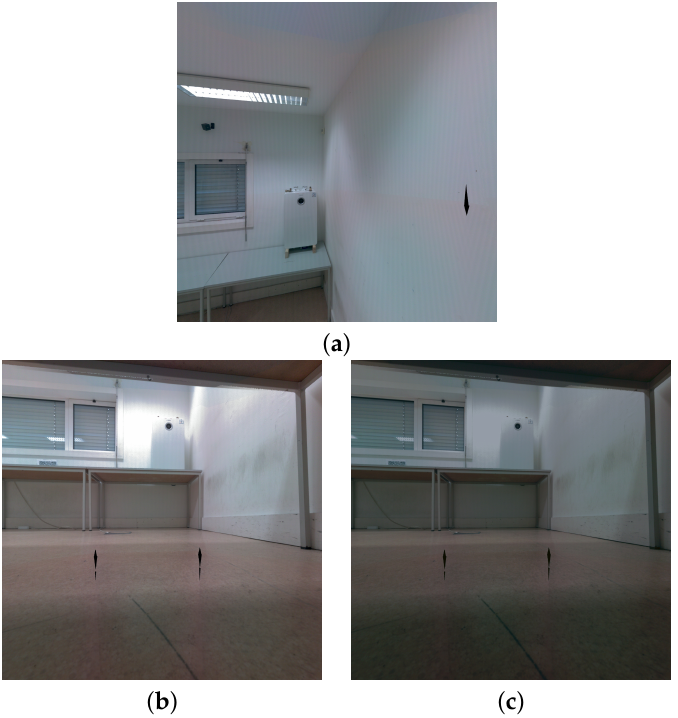
Figure 7. Example of the color correction for a pair of images: ( a ) Chosen reference camera (source image S ); ( b ) Original target image T ; ( c ) Color corrected target image ˆT .